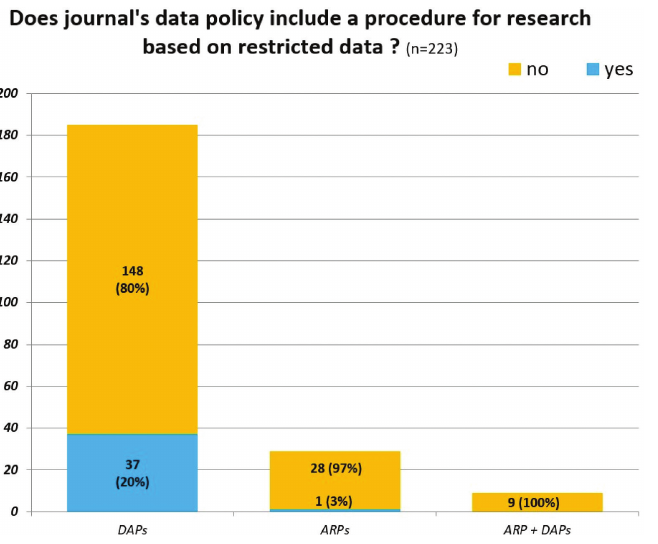
Fig. 3: Journals with procedures for research based on restricted data.